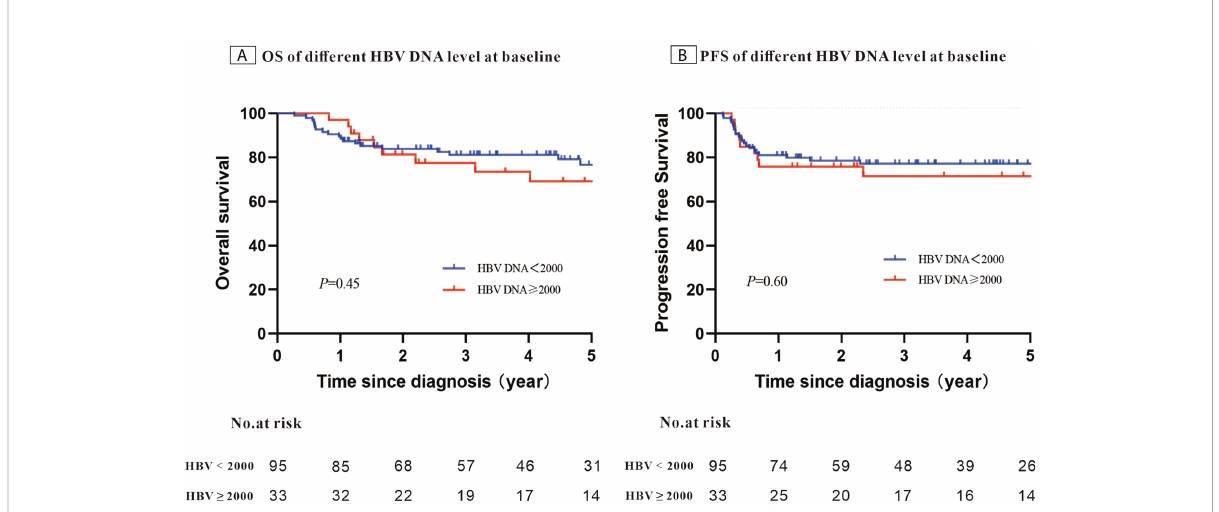
FIGURE 2 Kaplan – Meier survival curves for patients with Hepatitis B surface antigen (HBsAg)-positive diffuse large B-cell lymphoma (DLBCL) strati fi ed using the patients ’ Hepatitis B virus (HBV) DNA level at baseline (N =